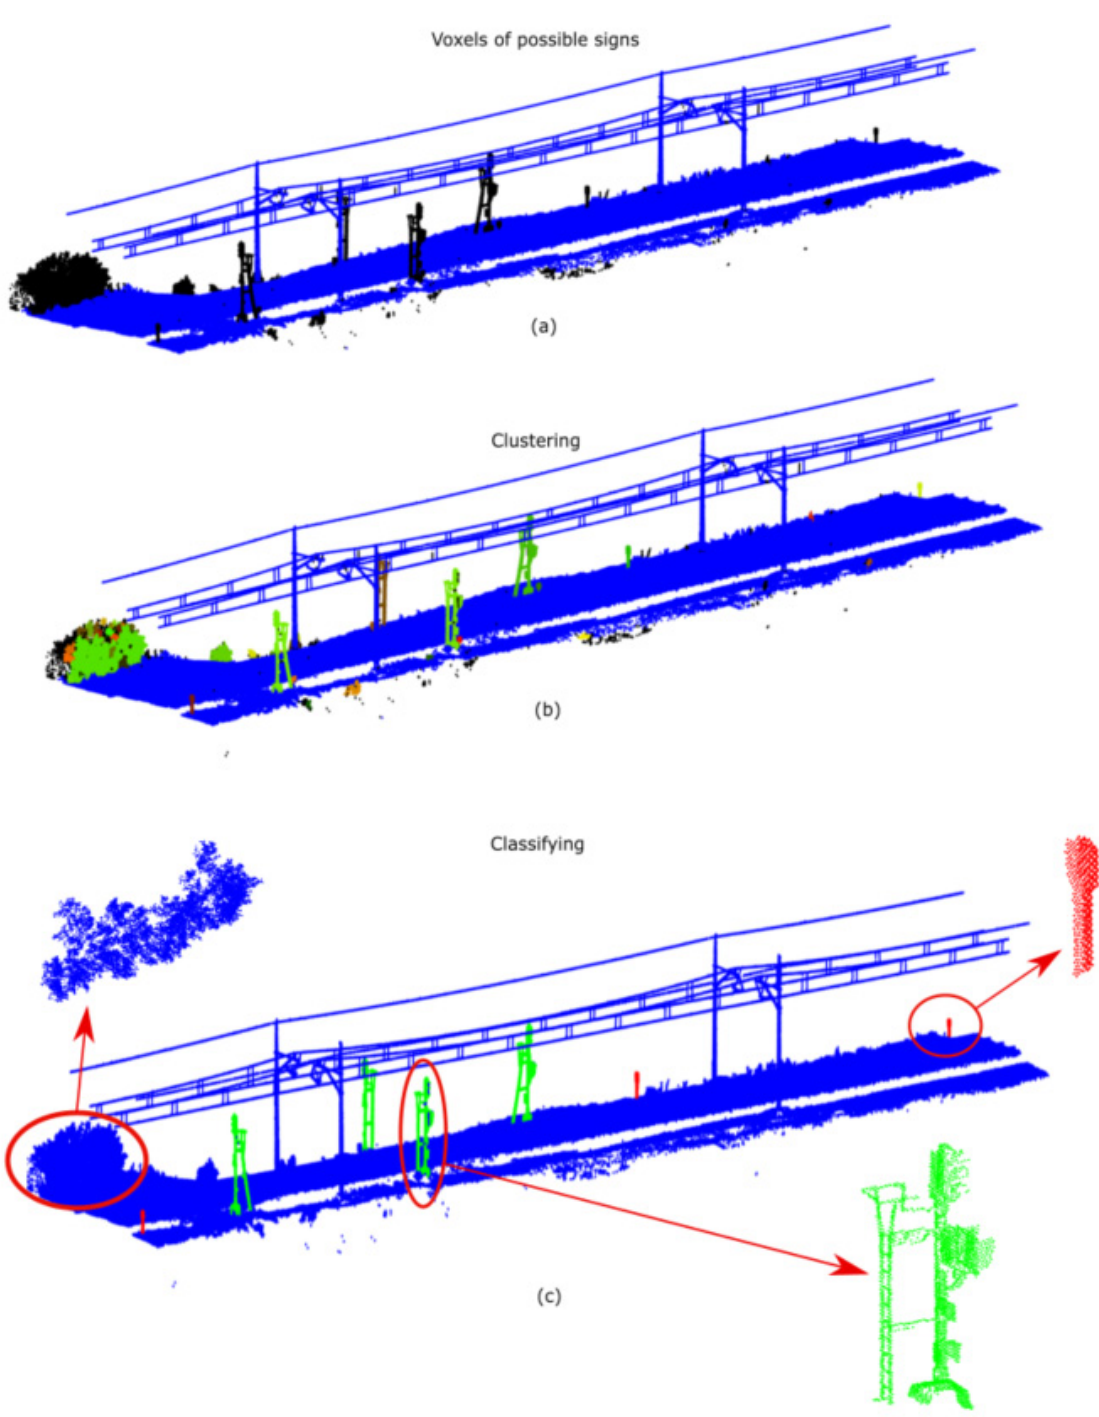
Figure 10. Signage elements’ segmentation workflow: ( a ) voxels of possible signage elements coloured in black; ( b ) clustered voxels, each cluster as a different colour; ( c ) signage elements, each type of element as a different colour.